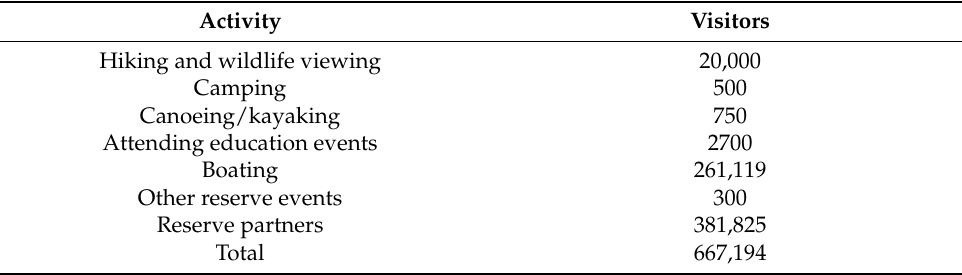
Table 4. Estimated annual visitors to the Rookery Bay Reserve by activity